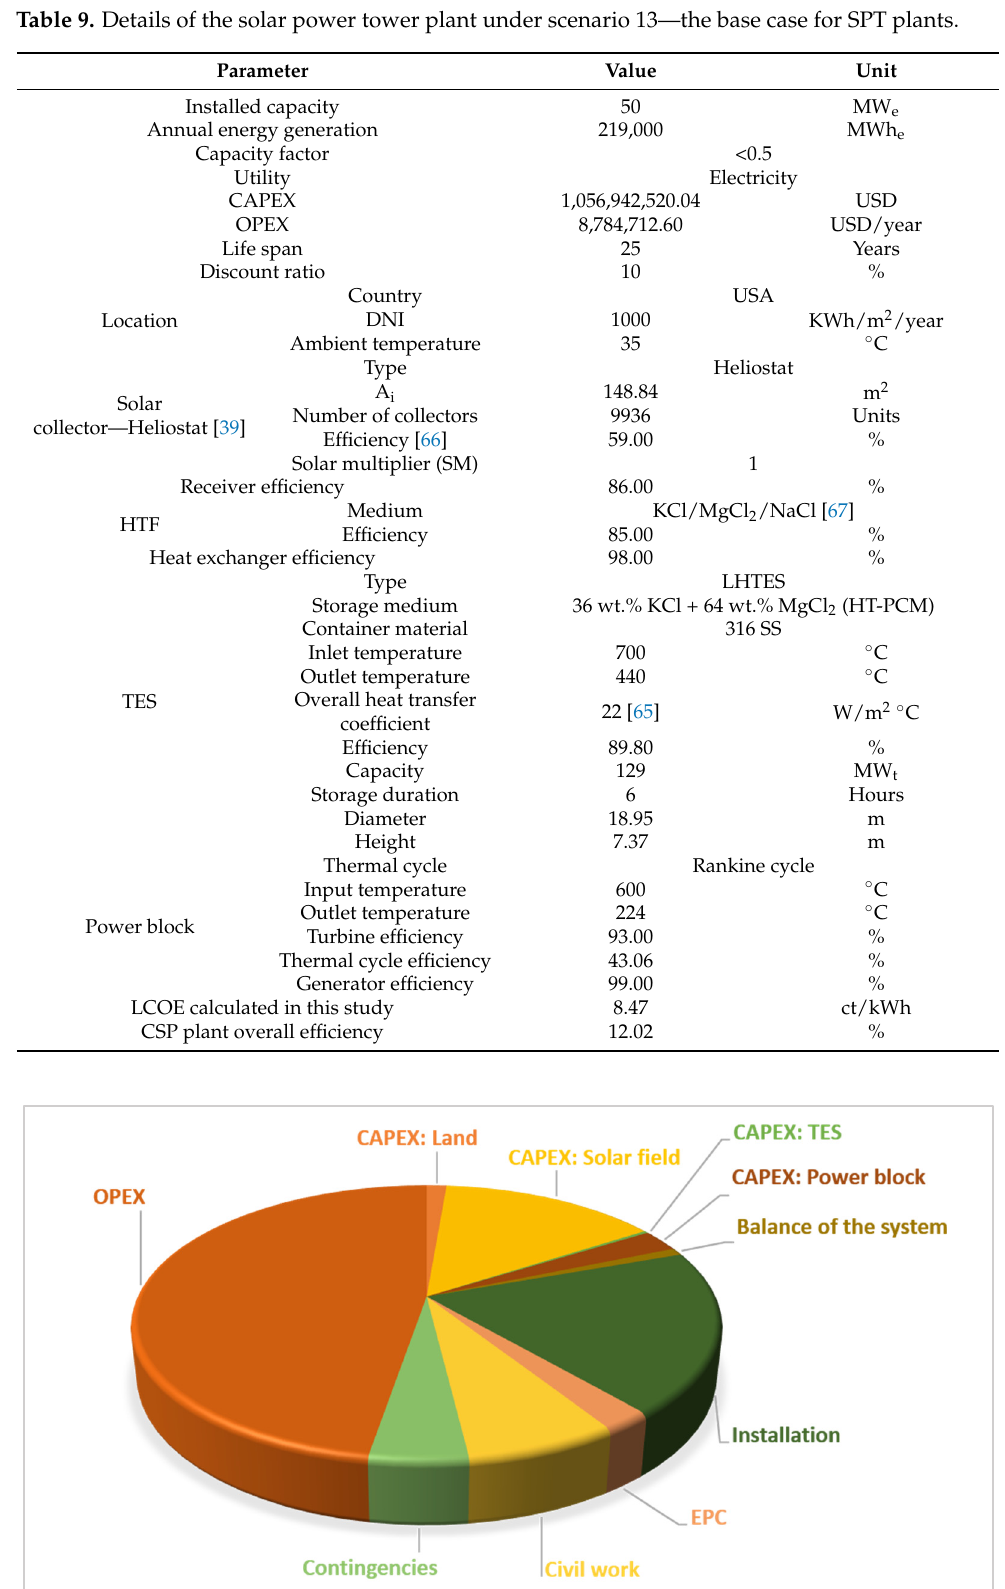
Table 9. Details of the solar power tower plant under scenario 13—the base case for SPT plants.